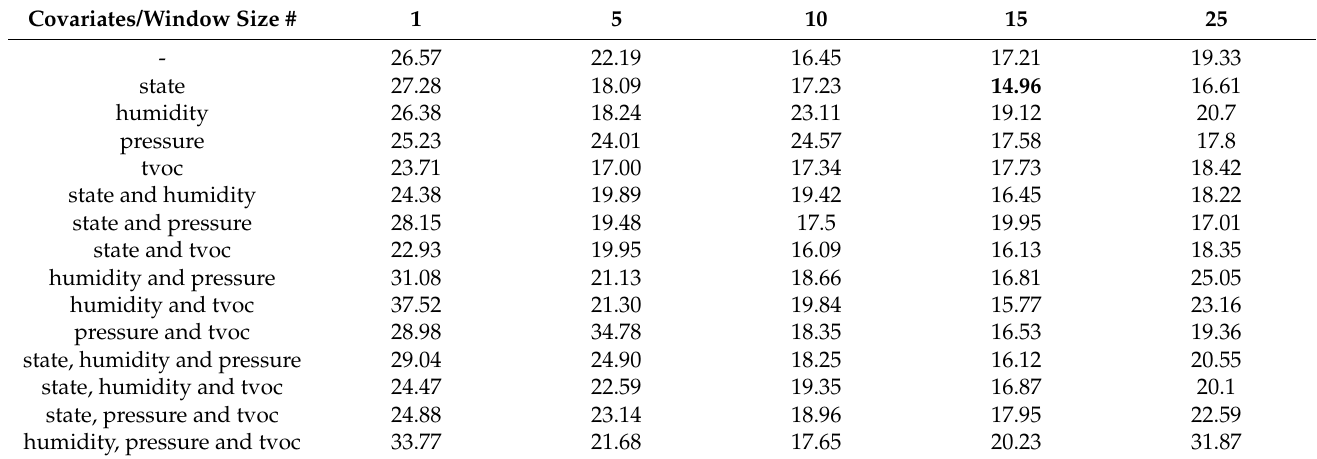
Table 1. RMSE for each model built with each combination of covariates (all of them include the radon level) and for each number of previous samples used.